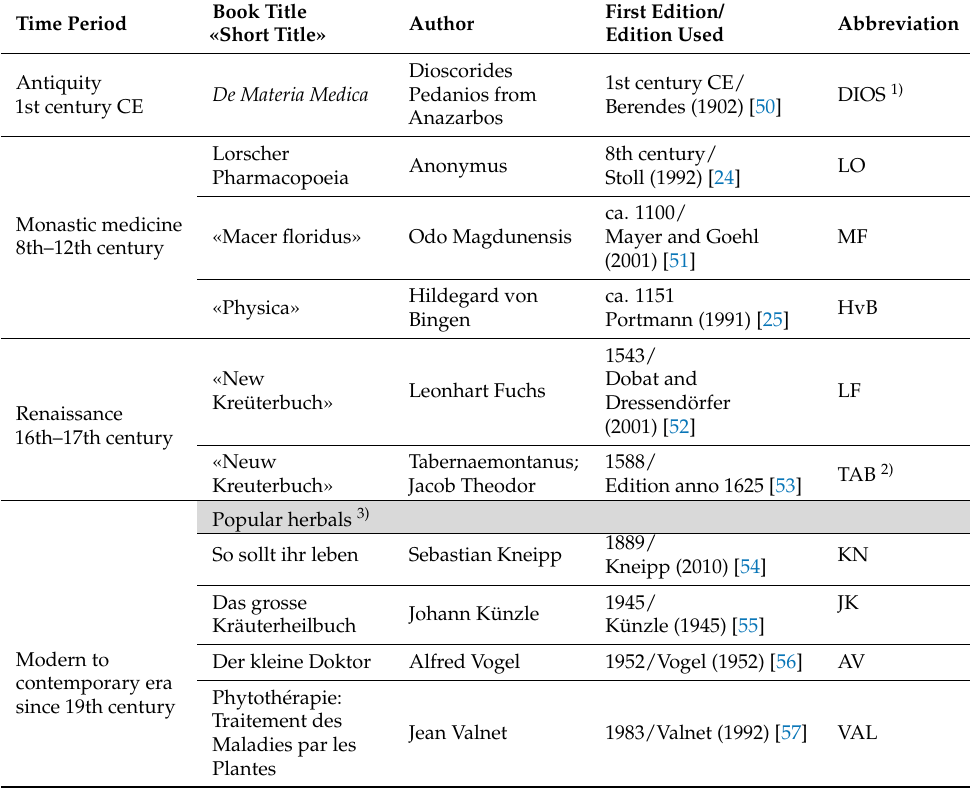
Table 1. Books used for the analysis of use